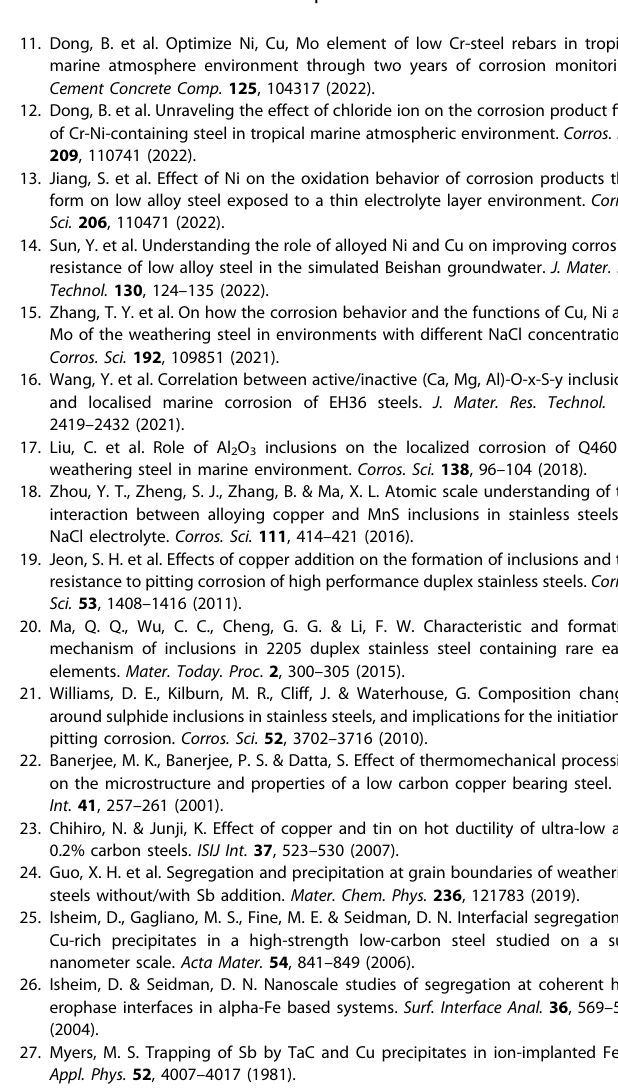
Fig. 16 Schematic diagram of local corrosion of Cu-containing inclusion. a Characteristics of the distribution of alloying elements in the steel matrix; b localized corrosion occurs preferentially in the area of inclusions; c Cu and Sb are involved in the localized corrosion of inclusions; and d localized corrosion development and Cr in the cementite is involved in the corrosion